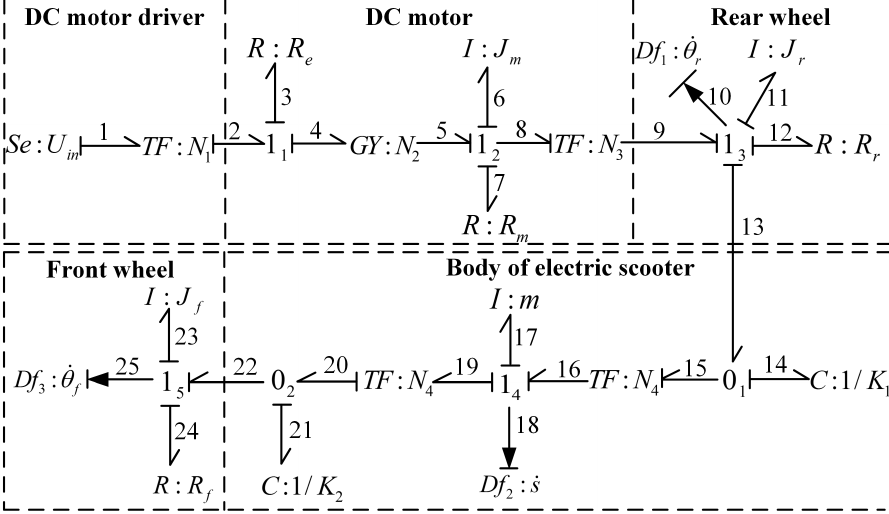
Figure 2. DBG model of electric